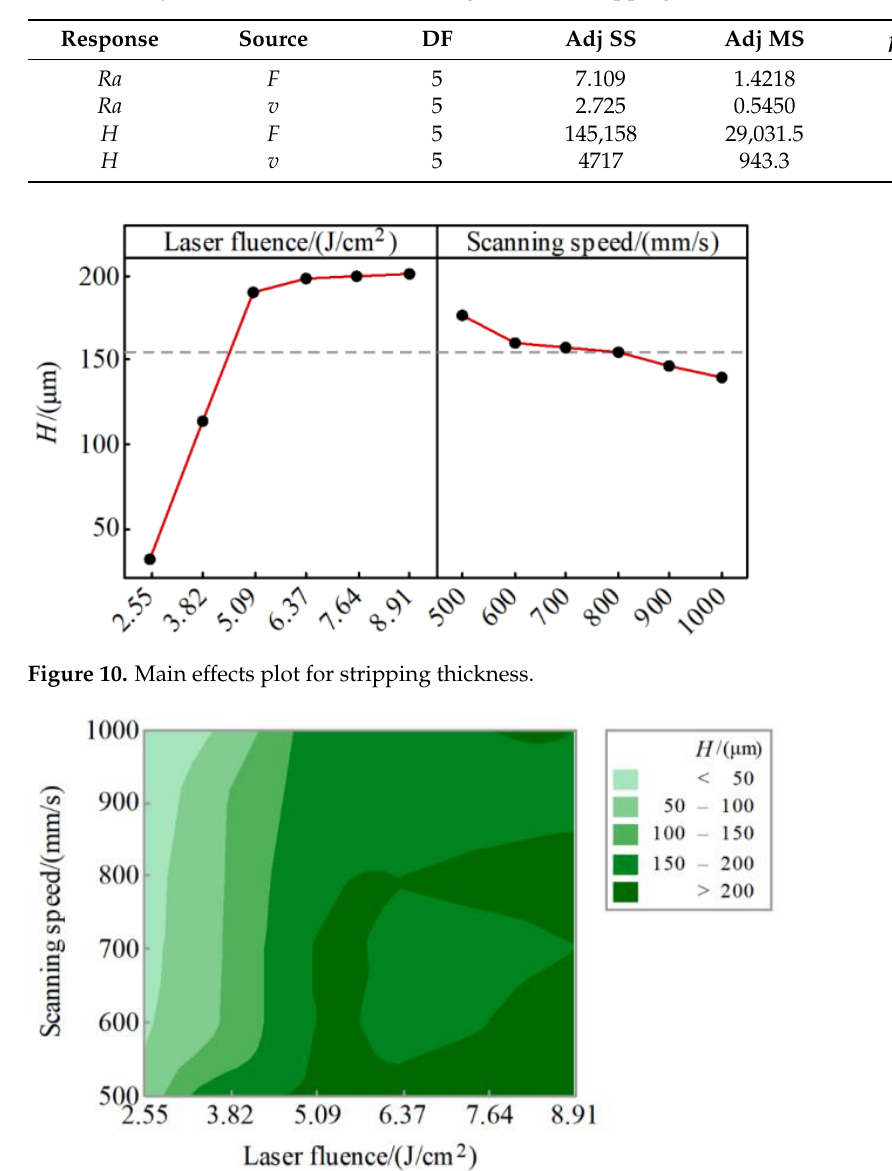
Figure 11. Contour plot of stripping thickness.